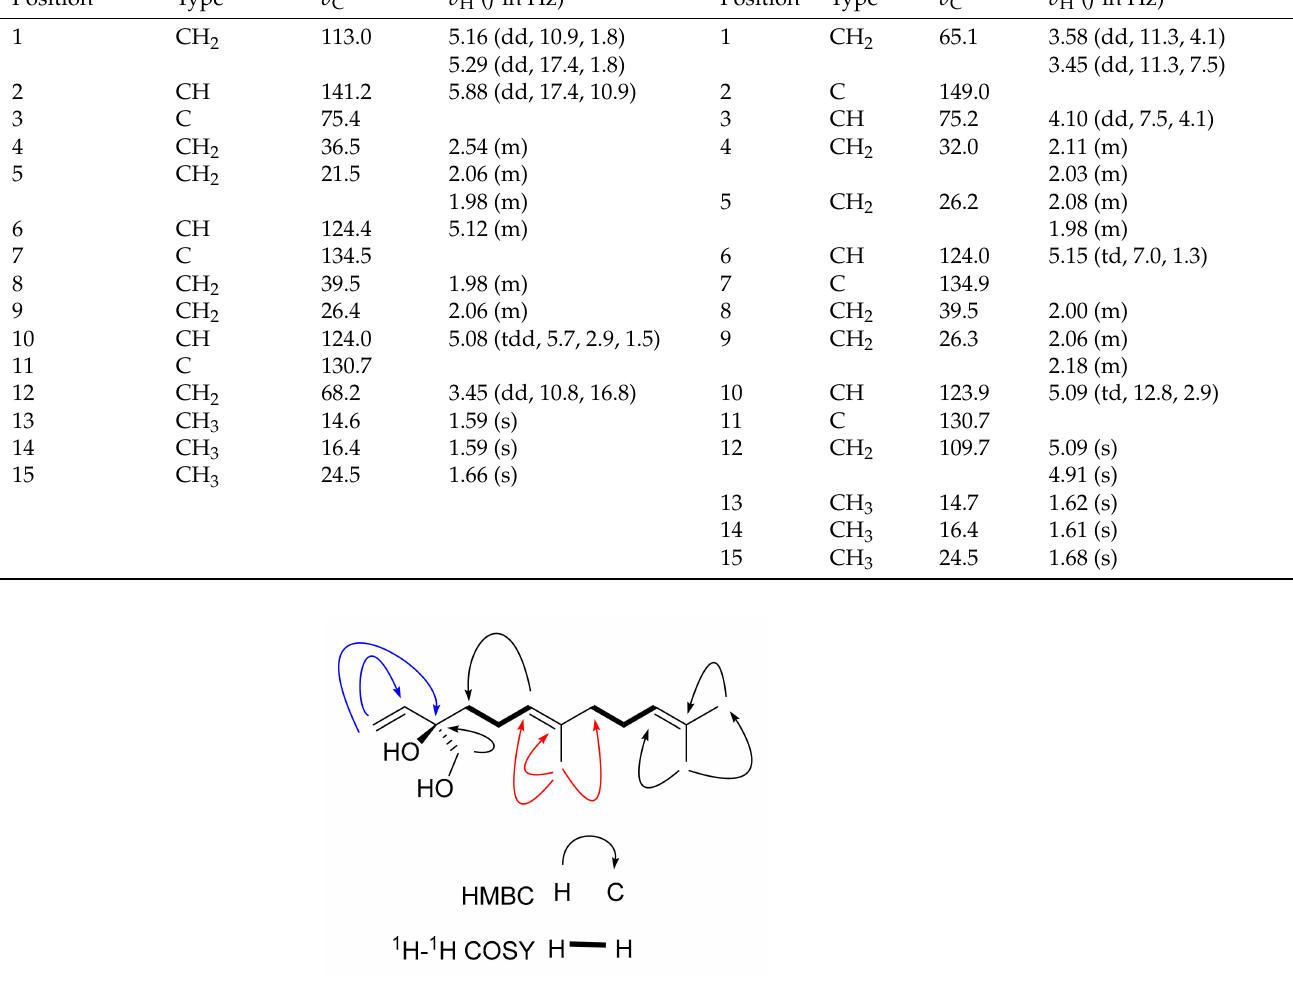
Figure 14. Key HMBC ( → ) and 1 H- 1 H COSY ( Figure 3. Key HMBC ( → ), 1 H- 1 H COSY( ) and ROESY ( ↔ ) correlations for Compound 1.